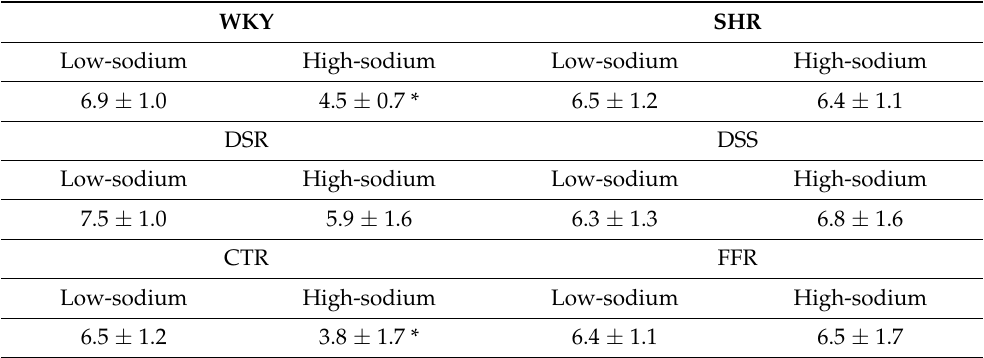
Table 1. Insulin binding characteristics in kidneys of rat strains with hypertension associated with insulin resistance and hyperinsulinemia maintained on a low-sodium or high-sodium